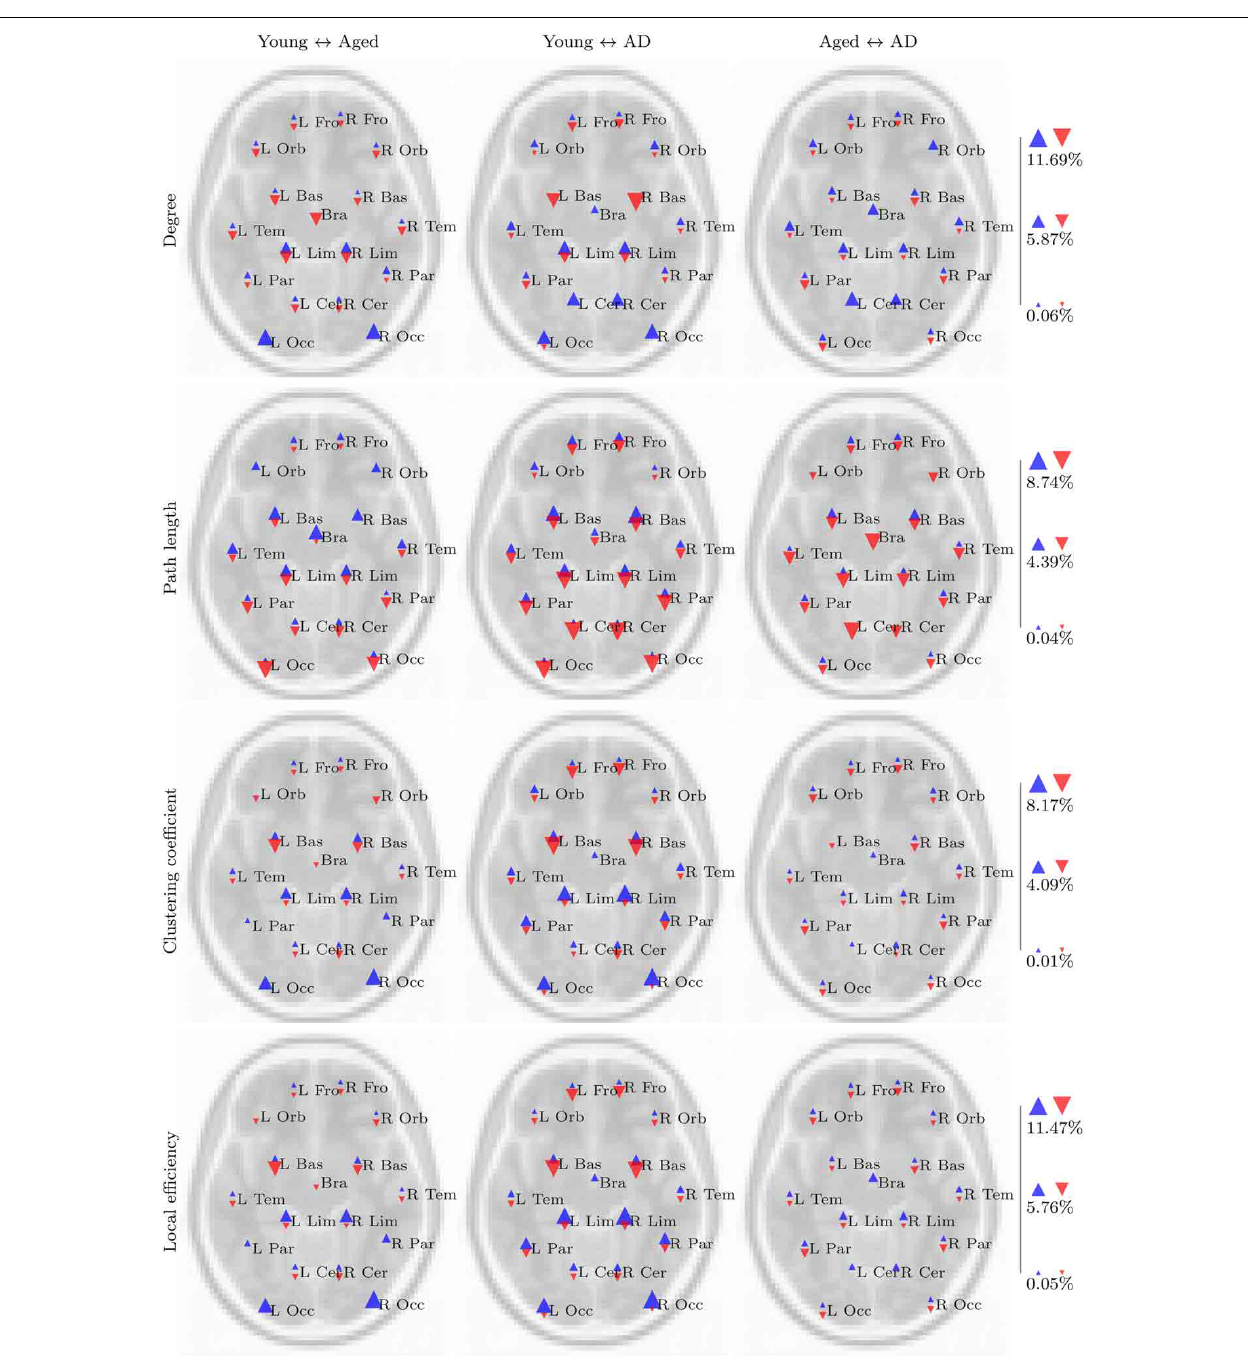
FIGURE 6 | Summary of regional group differences in resting state